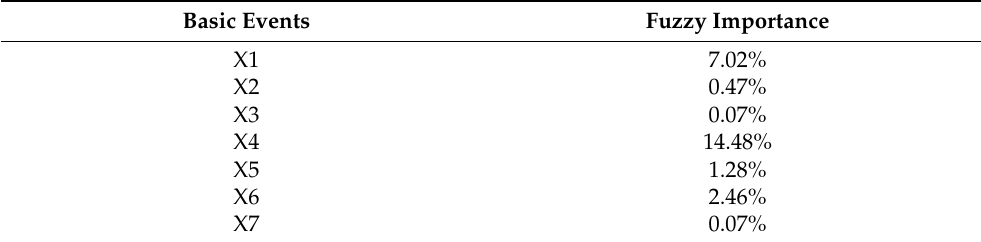
Table 6. Fuzzy importance of each basic